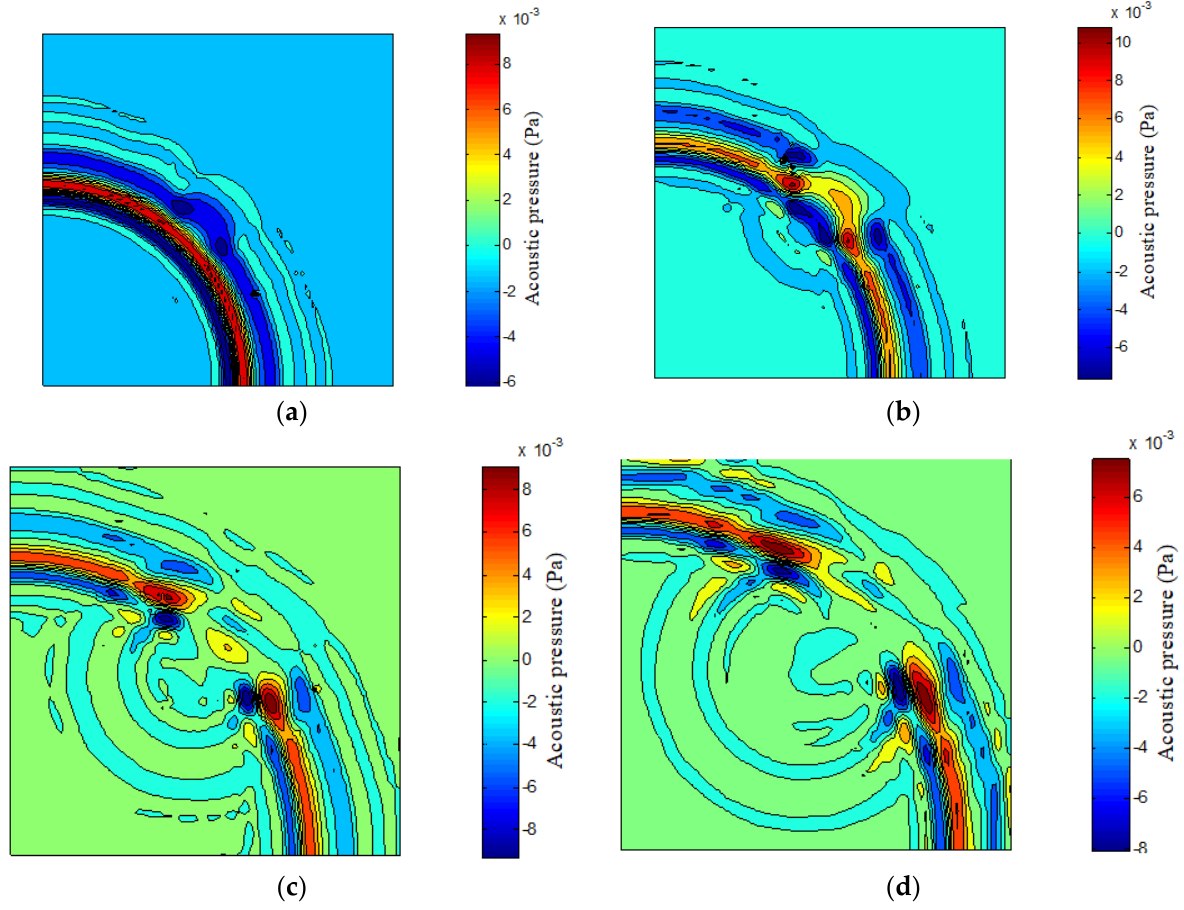
Figure 20. The computed FEM-Q4 results of the acoustic wave scattering by irregular object in the whole problem domain for several observation time points: ( a ) t = 0.7 s; ( b ) t = 0.8 s; ( c ) t = 0.9 s; ( d ) t = 1 s.